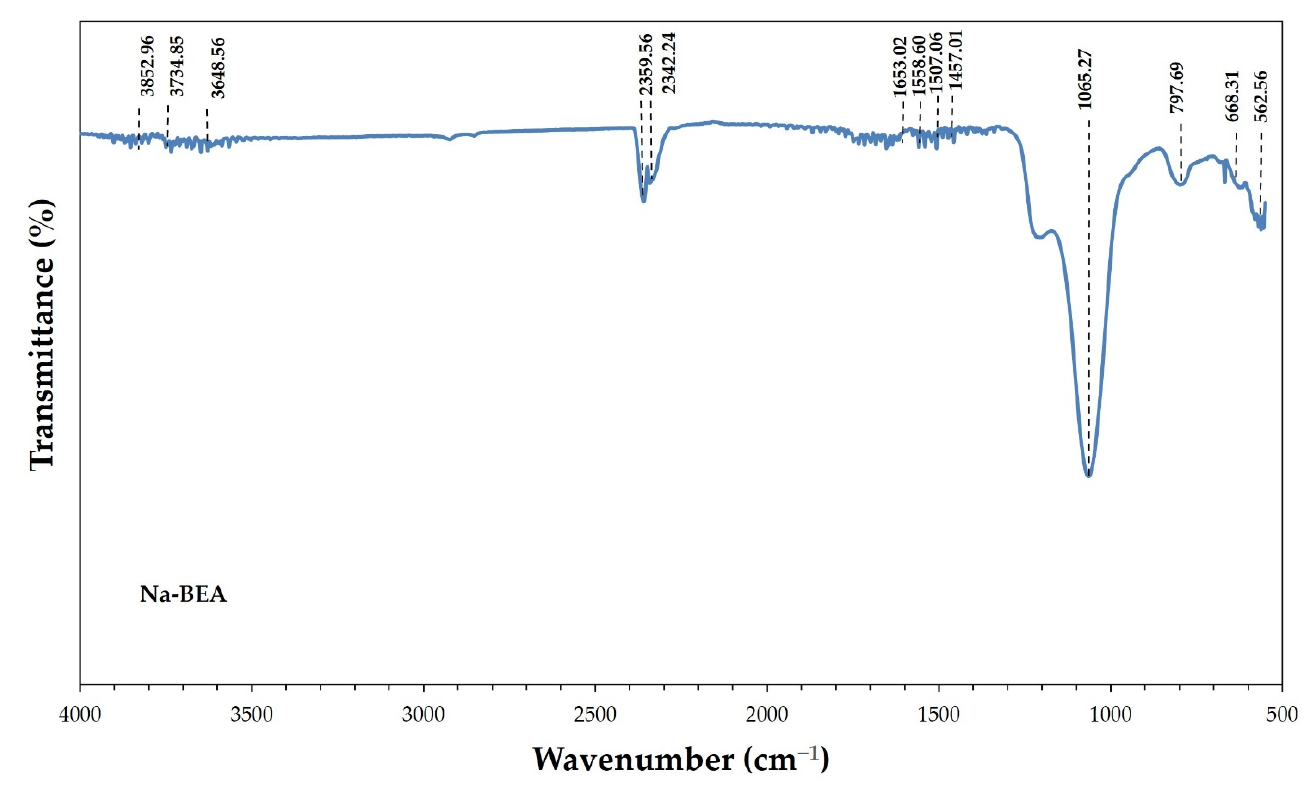
Figure 4. ATR-FTIR for Na-BEA zeolite.